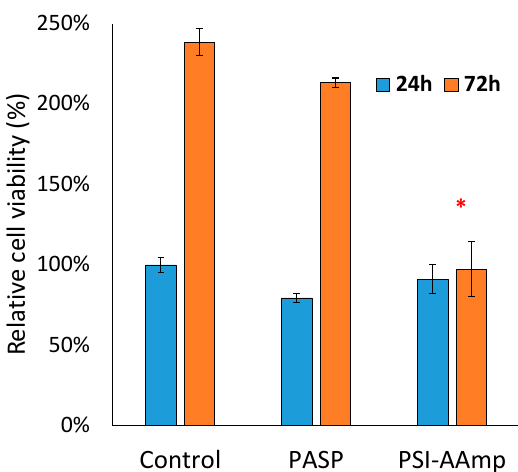
Figure 6. Relative viability of MG-63 cells 24 and 72 h after incubation with PASP or PSI-AAmp. The results were normalized to the UV absorbance of the 24 h control. The data are represented as arithmetic mean ± SEM (standard error of the mean). * significant difference (p < 0.05) compared to the control at the same time point.